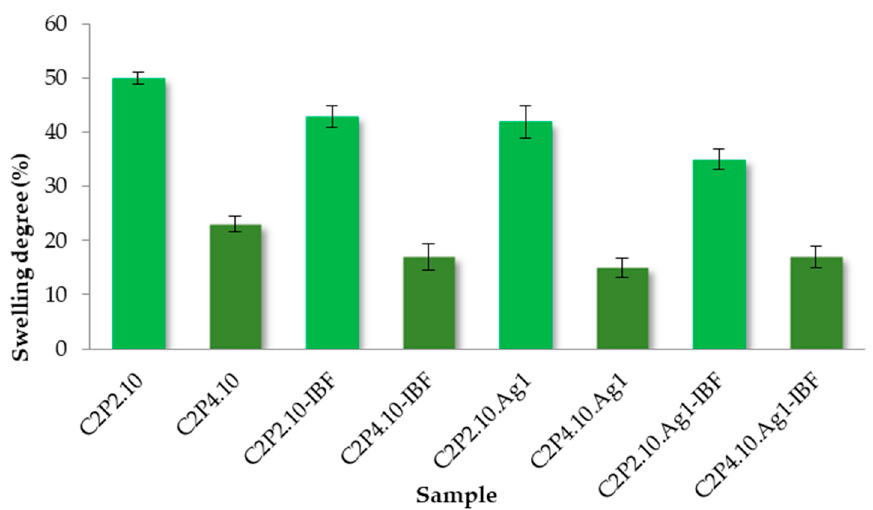
Figure 8. The swelling degree of the films after 24 h in PBS (pH = 6.8).